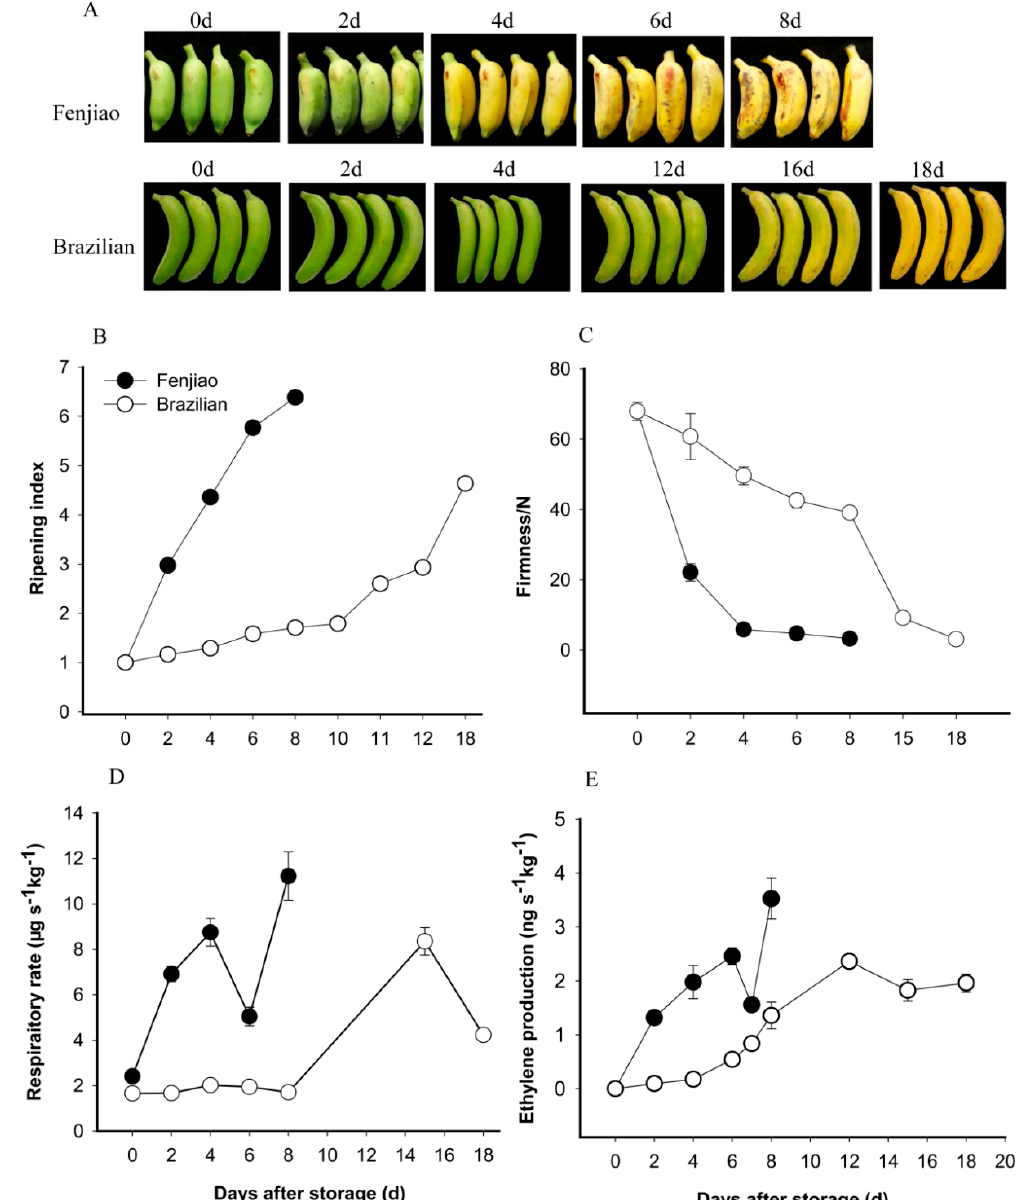
Figure 1. The ripening profiles of Brazilian and Fenjiao banana fruit. ( A ) Pictures of Fenjiao and Brazilian banana fruit during storage at room temperature (22 ± 1 °C); ( B ) fruit ripening index; ( C ) fruit firmness; ( D ) fruit respiration rate; and ( E ) ethylene production. The values presented were obtained from three independent biological replicates. The bars indicated the standard errors (mean ± SE).